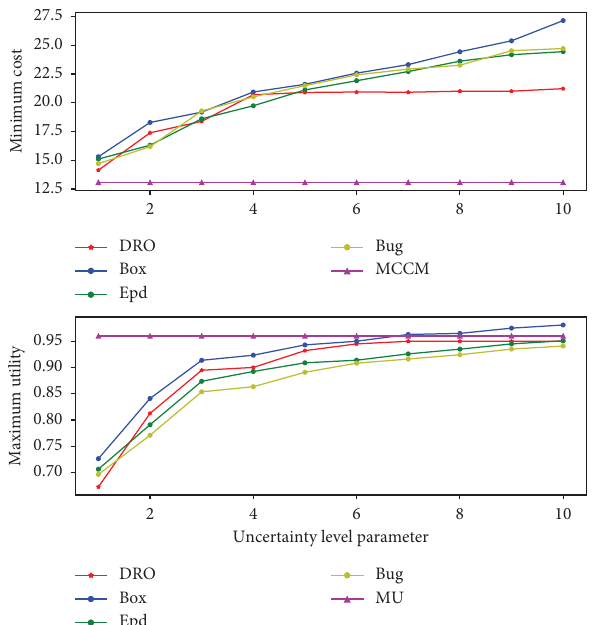
Figure 2: Scenario 2: minimum cost and maximum utility of diferent MCCMs under diferent